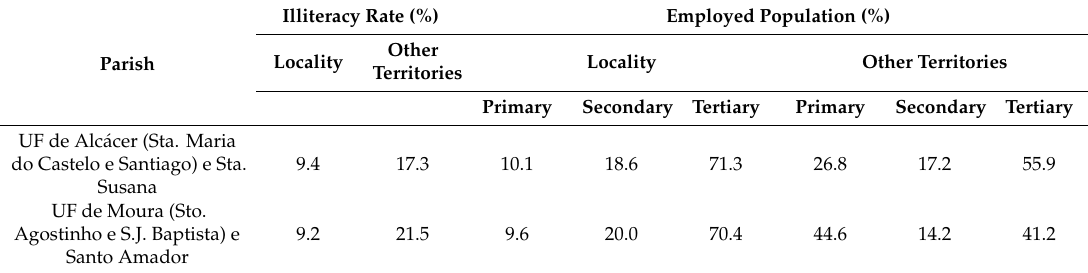
Table 11. Illiteracy rate (%) and employed population (%) in localities with the municipal headquarters, and other territories belonging to APU (TIPAU) and Code 2 (DEGURBA)